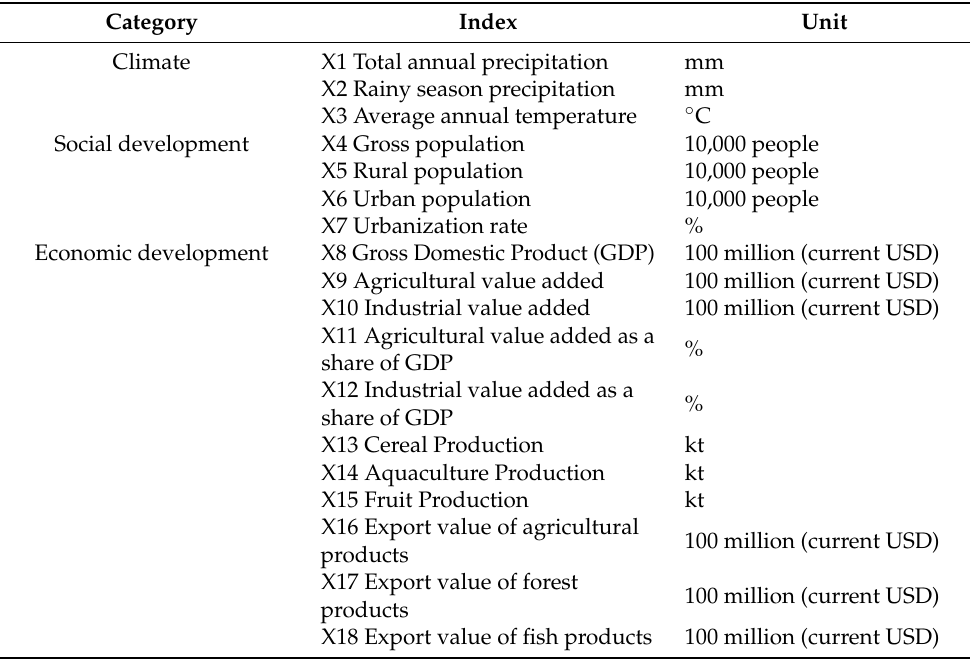
Table 2. Indicators and their categories of economic and social development statistics from 2000 to